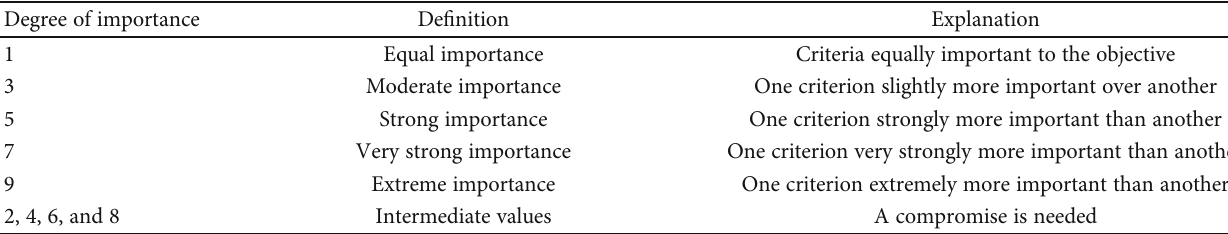
Table 2: Fundamental scale for pairwise comparisons [34, 35].